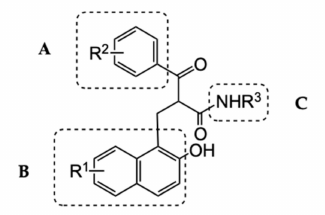
Figure 4. General structure of the SIRT2 inhibitors. Fragment ( A ) aryl group; ( B ) 2-hydroxynaphthyl group; ( C ) aliphatic amide